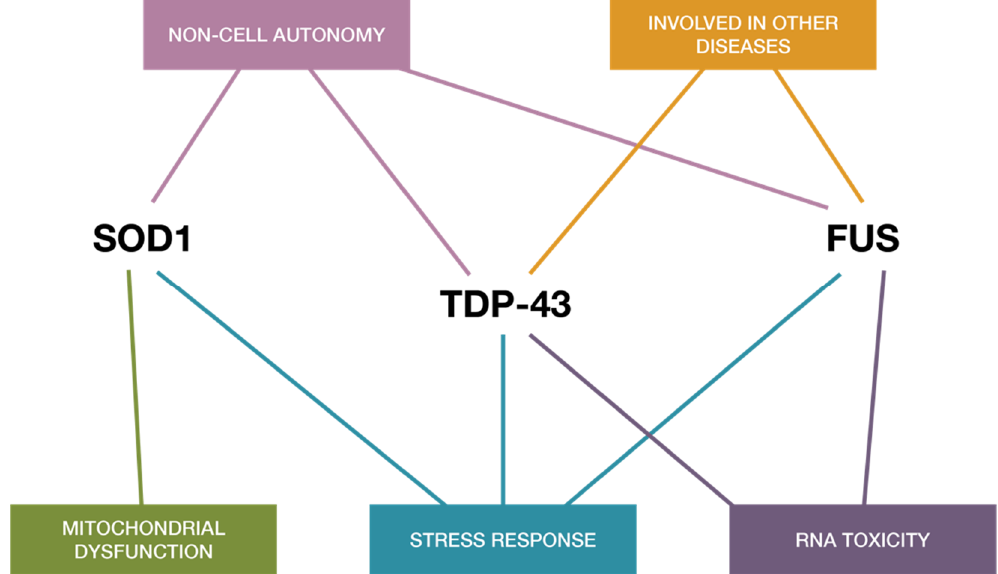
Figure 2. Common shared pathways in ALS and functional similarities shared between TDP43, SOD- 1, and FUS. The three proteins appear to share mechanisms related to toxicity mechanisms and RNA toxicity, cellular stress response, and mitochondrial impairment and cell autonomy, implying functional synergies in ALS disease